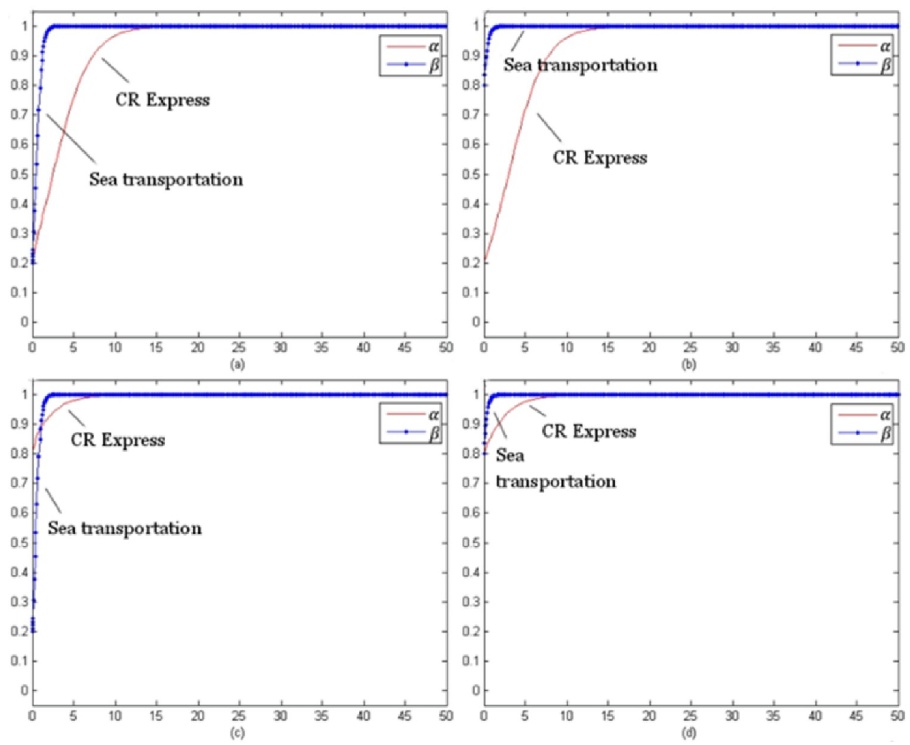
Fig 10. Evolution trend of competition game of industrial accessories transportation (without